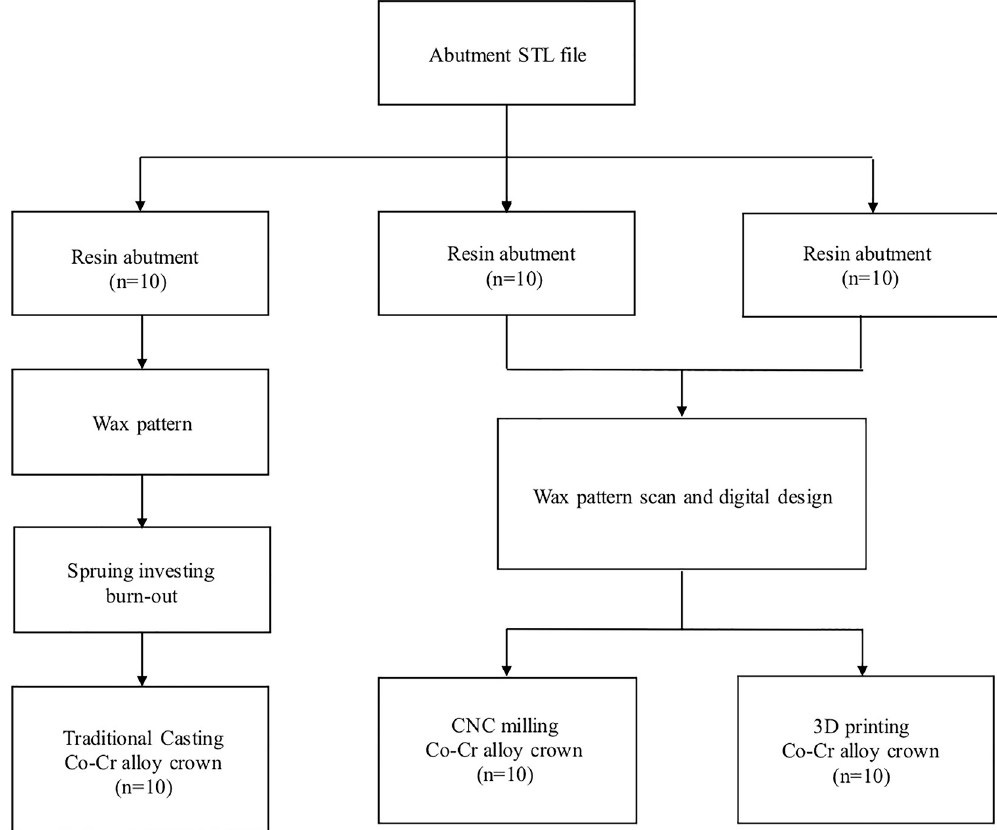
Fig 3. Flowchart of the crown fabrication